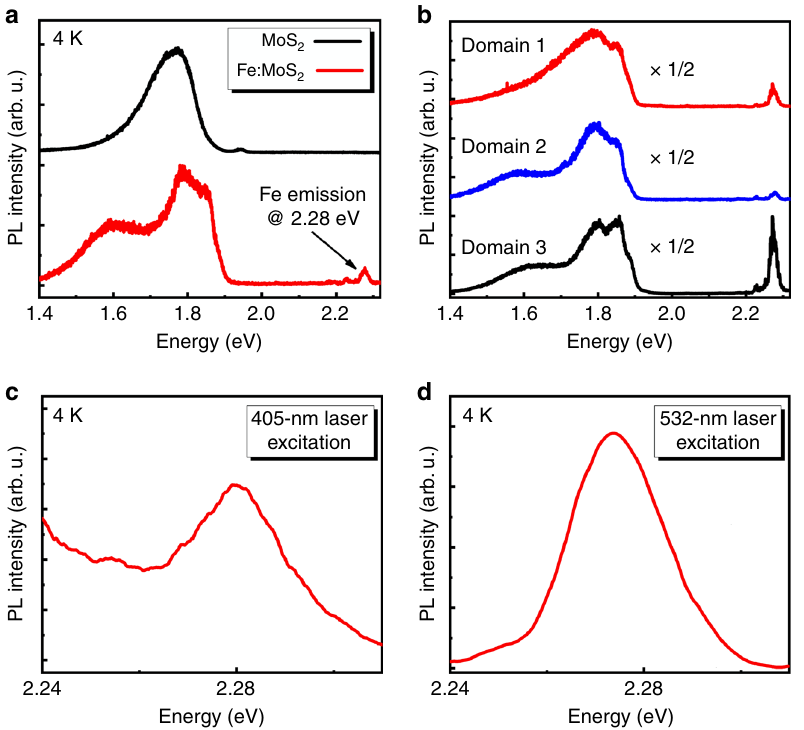
Fig. 2 Fe-related spectral transition. a PL spectra of as-grown MoS 2 (black) and Fe:MoS 2 (red) measured at 4 K. The emergence of an emission peak at 2.28 eV in Fe:MoS 2 is clearly visible. b PL spectra of Fe:MoS 2 for three different domains revealing a high spatial sensitivity of the observed transition. For illustrative purpose, the Fe:MoS 2 excitonic emission region below 2 eV is scaled down by a factor 2. c , d PL spectra of the 2.28 eV emission peak excited by 405 nm and 532 nm pump laser wavelength, respectively.